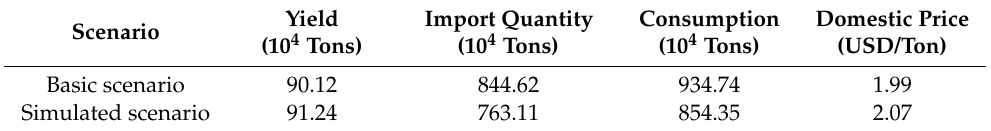
Table 8. Simulation results of changes in barley production and consumption in China (Scenario 1).